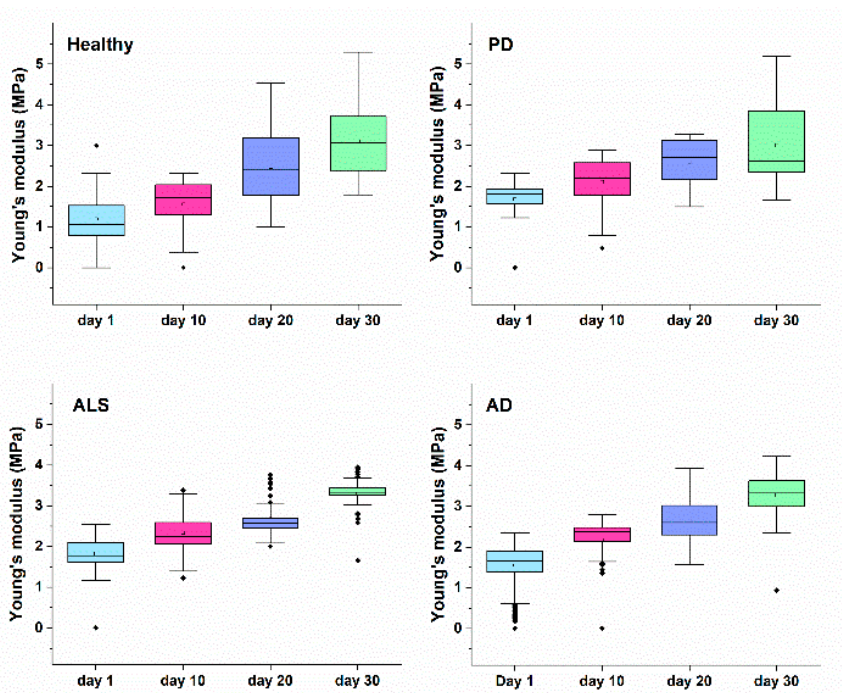
Figure 8. Young’s modulus of healthy, PD, ALS and AD RBCs along the process of cells aging.